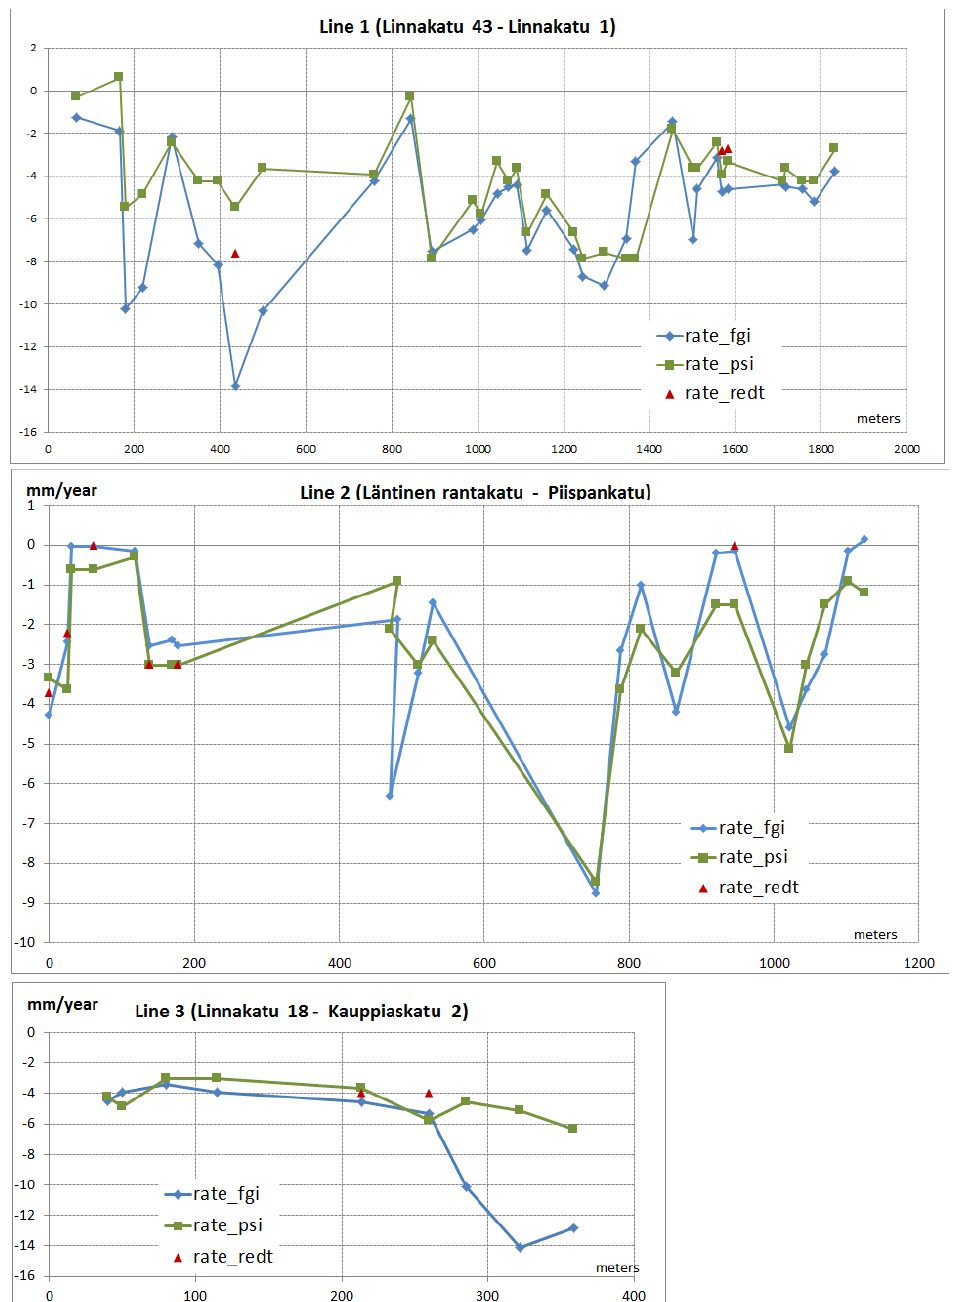
Figure 9. The FGI precise leveling results (annual subsidence rates) along three leveling lines and the PS observations along the lines. Note that the subsidence is not spatially